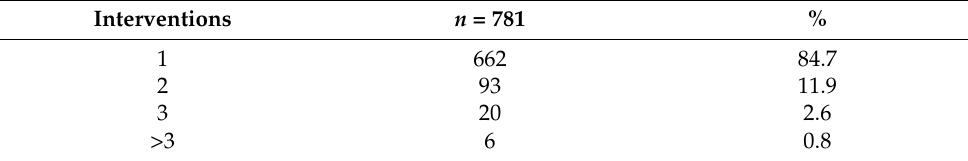
Table 1. Number and percentage of